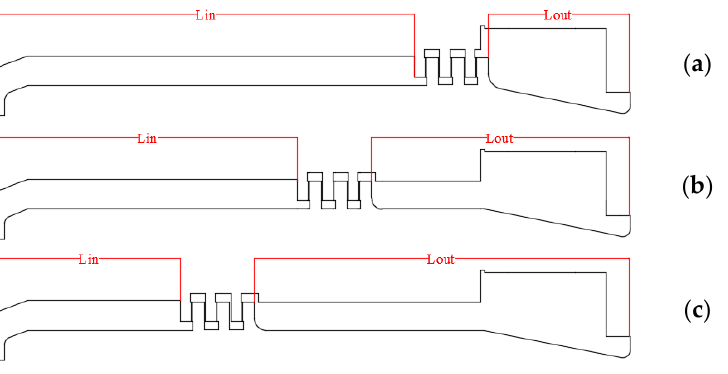
Figure 3. Seal locations of different models. ( a ) UC + 0. ( b ) UC + 300. ( c ) UC + 600.